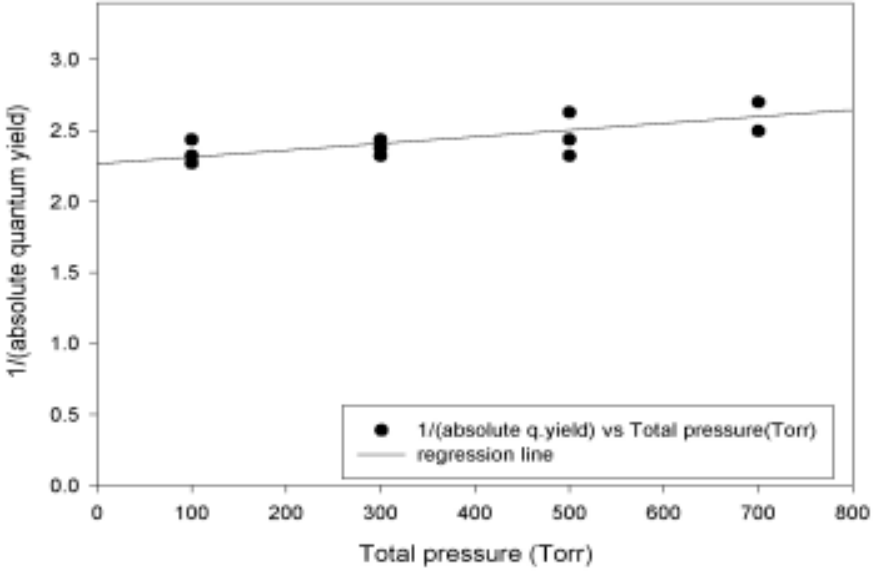
Figure 4. The pressure dependency of 1/(absolute quantum yields) in n -hexanal photolysis, at different total pressures of synthetic air (Stern-Volmers plot). If collisional deactivation is the only relaxation process, one should expect that the interception on the ordinate should be one. This is not the case, indicating that one or more other energy dissipating processes from photoexcited molecules are taking place. Possible explanations are given in the main